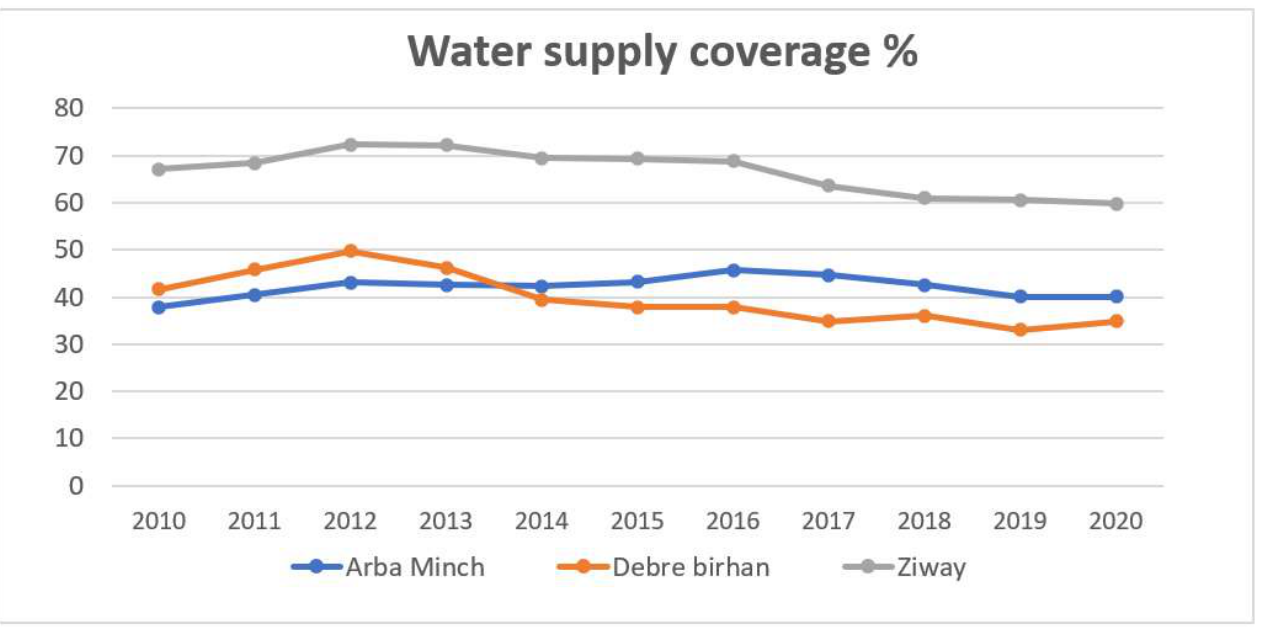
Figure 4. Water supply percentage coverage of the past 10 years at the three urban towns